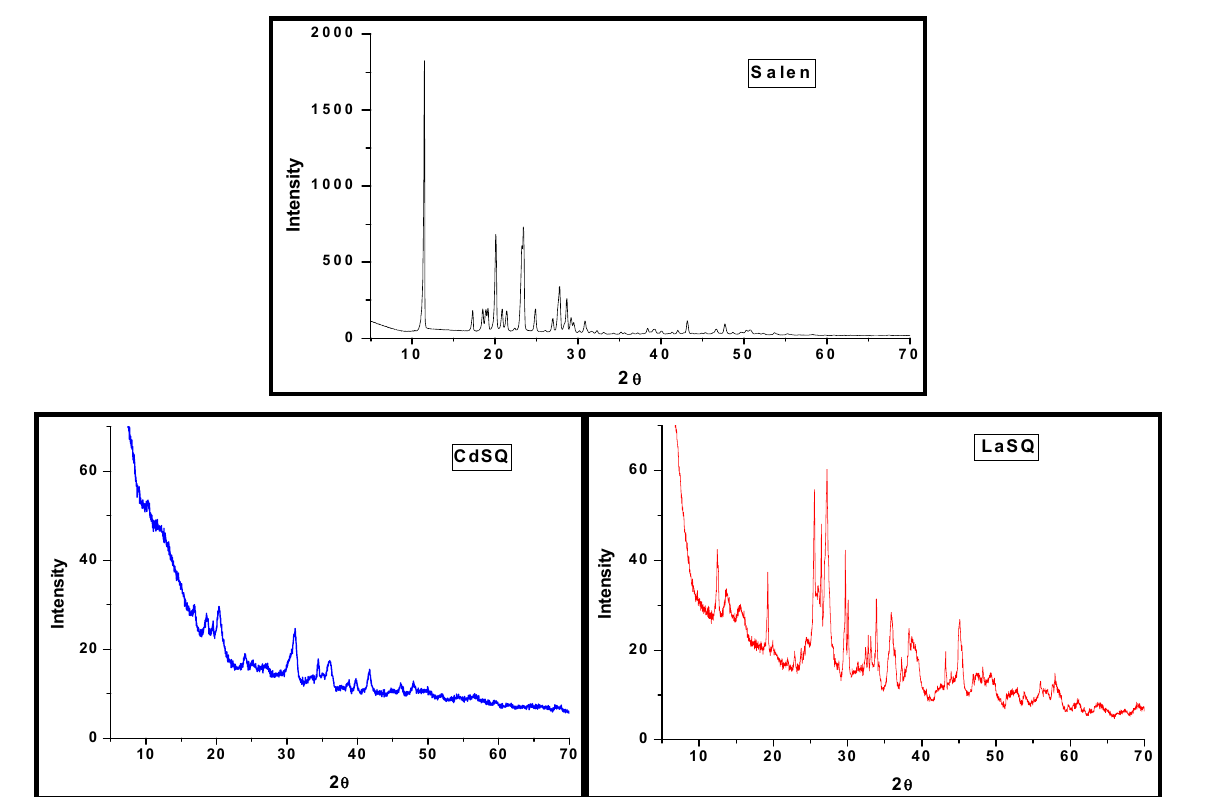
Figure 6. PXRD powder pattern of salen and its mixed CdSQ and LaSQ metal complexes with 8-hydroxyquinolone.